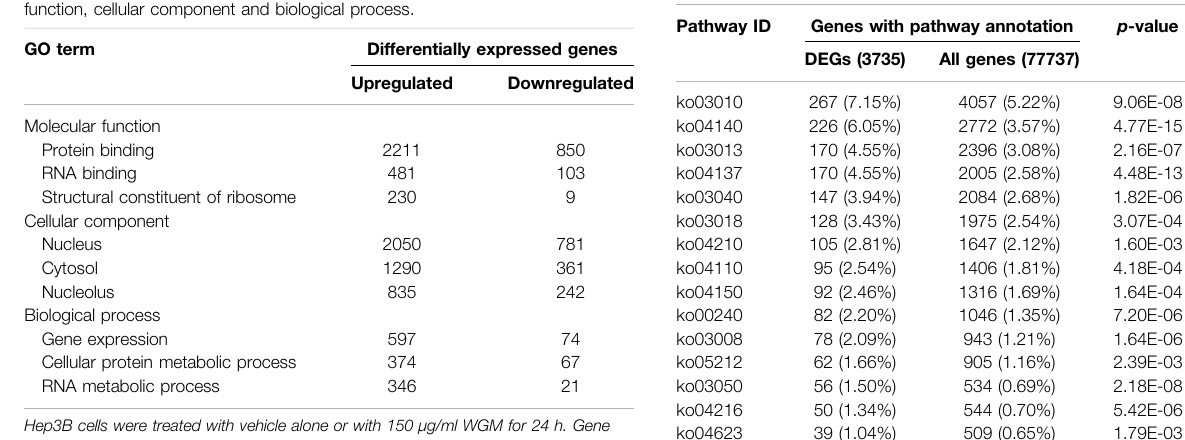
TABLE 2 | KEGG pathway analysis of differentially expressed genes (DEGs).